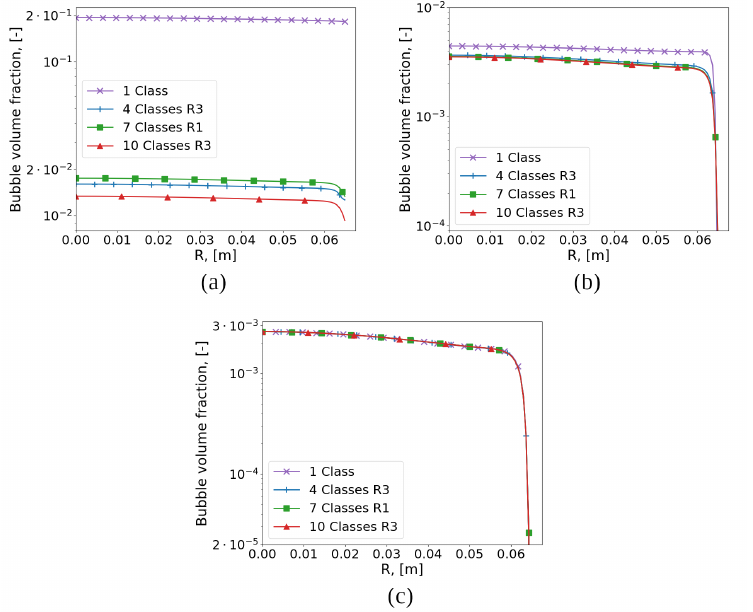
Figure 4. Radial profiles of the bubble volume fraction in the reference cross-section (see Figure 1)